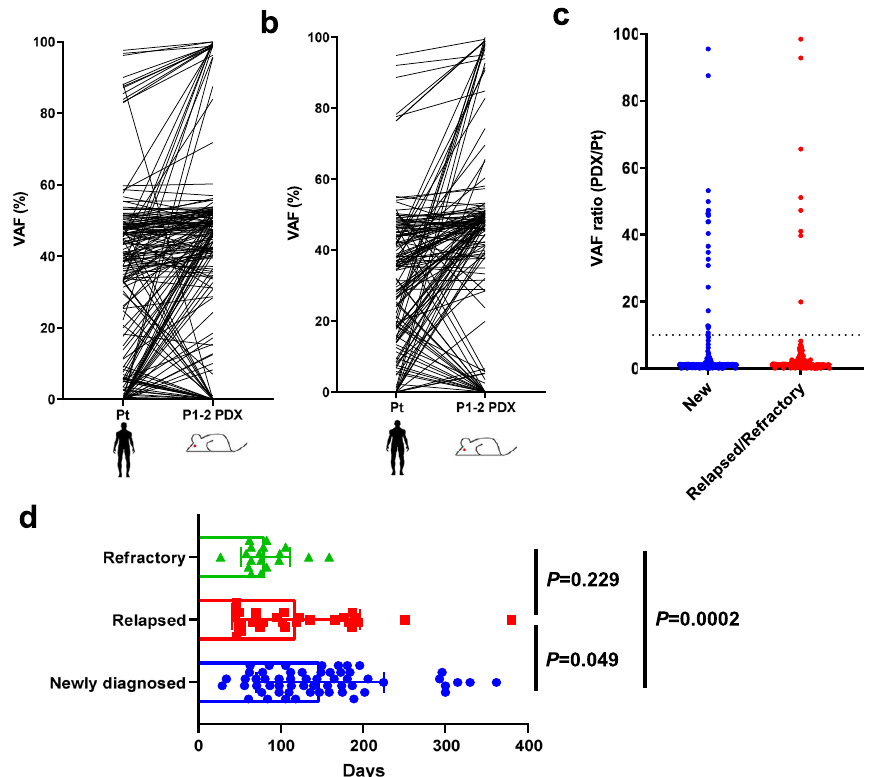
Fig. 3 Stable and rapid engraftment of relapsed/refractory AML into PDX. Changes in VAF from primary to PDX in samples from a newly diagnosed and b relapsed/refractory AML. c The ratio of VAF changes from patients to PDX (New, n = 169; Relapsed/Refractory, n = 137). The dotted line shows a cut-off of 10. d Duration from transplantation to engraftment in PDX of primary patients at diagnosis ( n = 58), relapse ( n = 29), or refractory ( n = 18) to initial chemotherapy. Data are presented as mean values + / – standard deviations. P -values indicate signi fi cance from the Mann – Whitney U -test. Source data are provided as a Source Data fi